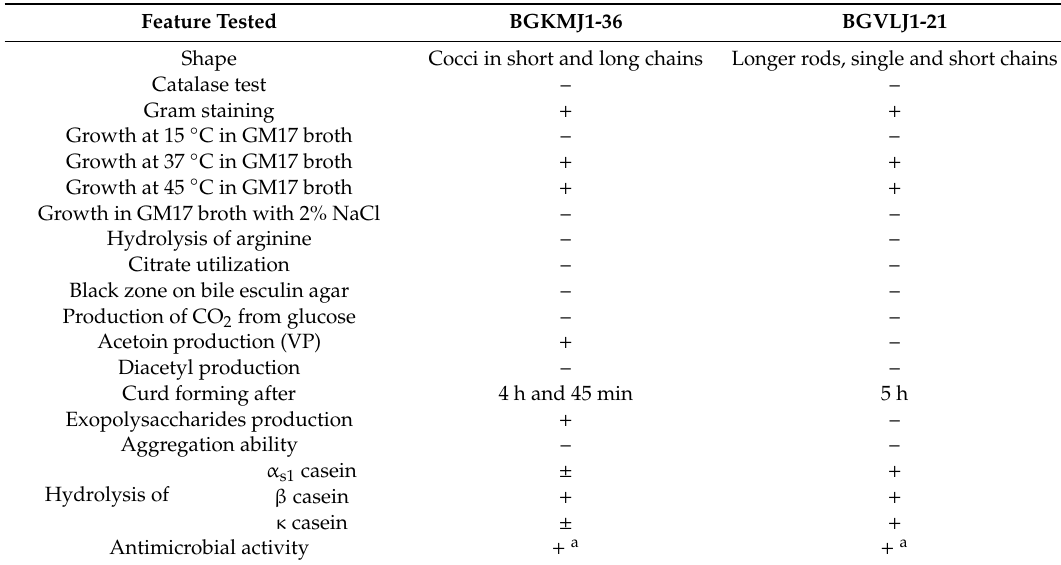
Table 2. Phenotypic, Biochemical, and Technological Characteristics of Streptococcus thermophilus BGKMJ1-36 and Lactobacillus bulgaricus